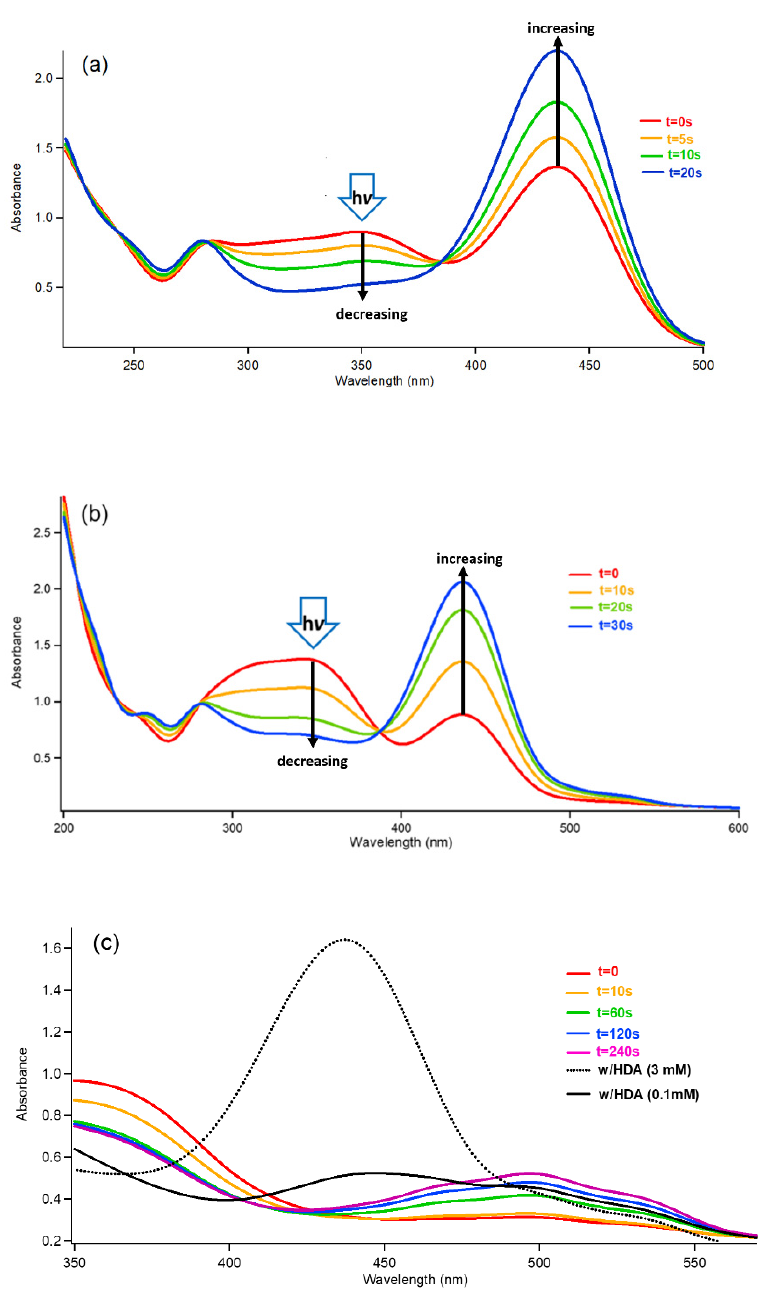
Figure 5. Irradiation of F1 solutions ( a ) 350 nm at initial pH = 3.7; ( b ) 350 nm at initial pH = 4.5; ( c ) 350 nm at initial pH = 5.2 ( AH + peak in dotted black formed by quenching with excessive 3 mM HDA at pH = 5.2 and AH + /A peaks in black formed by quenching with 0.1 mM HDA at pH = 5.2).